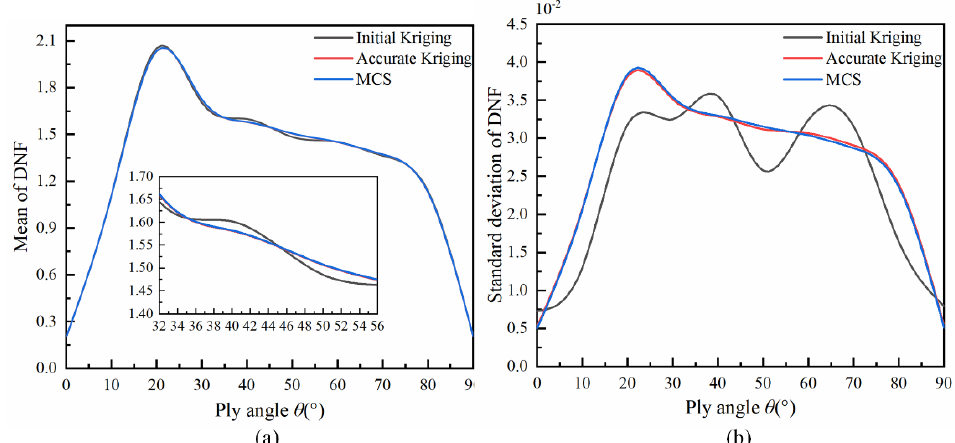
Figure 6. The mean and standard deviation of DNF for the seven-layer laminated composite cylindrical shells with clamped–supported boundary conditions. ( a ) mean, ( b ) standard deviation.